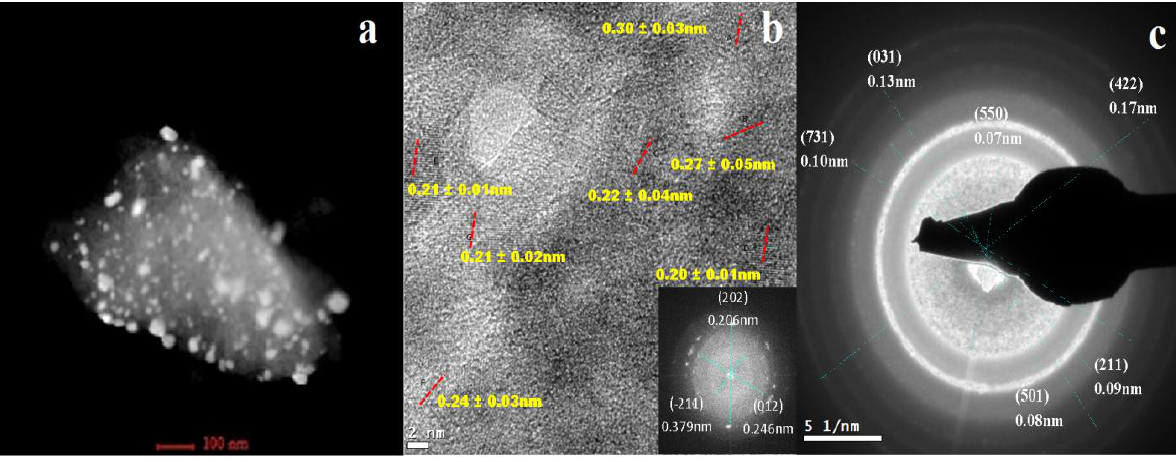
Figure 2. ( a ) STEM image of a grain of Al ( b ) high-resolution transmission electron microscopy (HRTEM) image and its Fourier transformed micrograph and ( c ) select area diffraction pattern (SADP) of the same